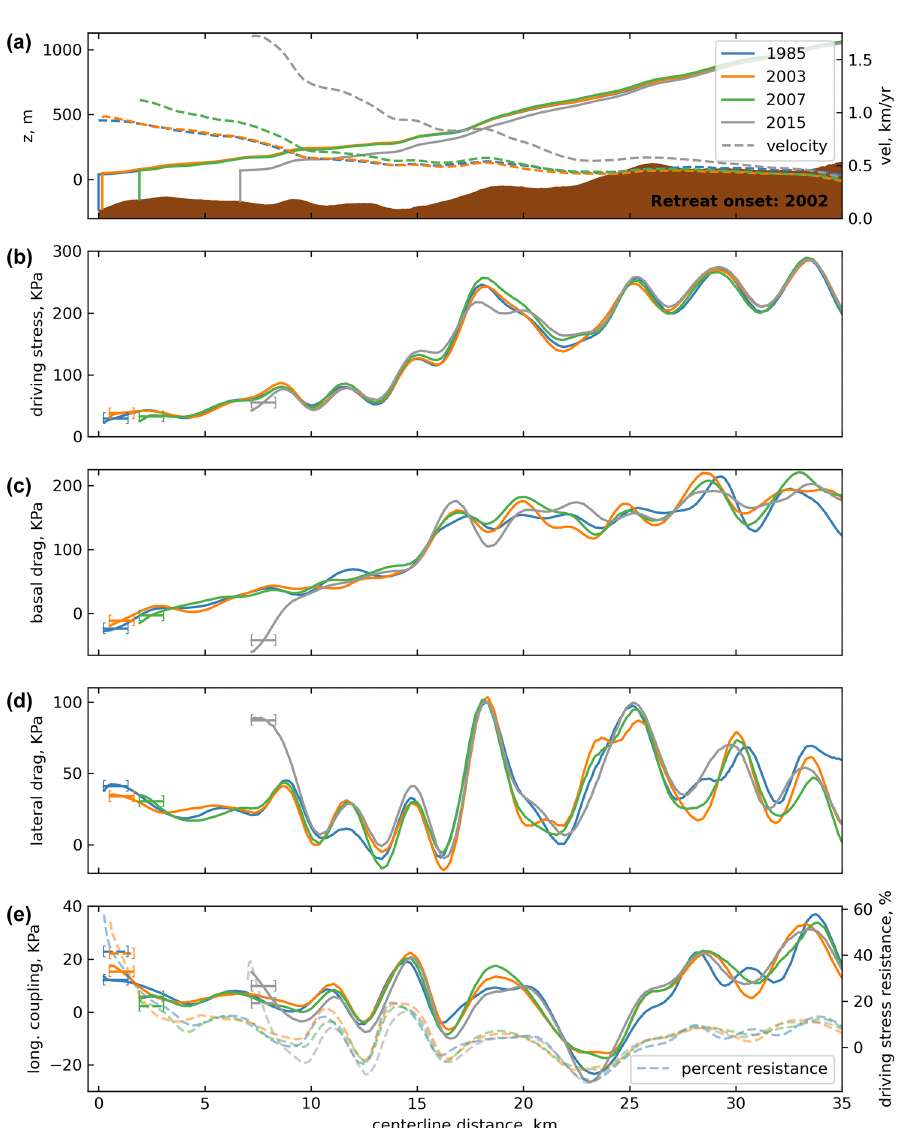
Figure 2. Time series of centerline dynamic components for Inngia Isbræ. Marked by the bracketed lines are the average values within one stress coupling length of the terminus at that time. (a) Surface and bed elevation and velocity profiles along-flow. Along-flow (b) driving stress, (c) basal drag, (d) lateral drag, and (e) longitudinal coupling and percentage of driving stress supported by longitudinal coupling. Positive values of driving stress act in the direction of flow; positive values of all other stresses oppose